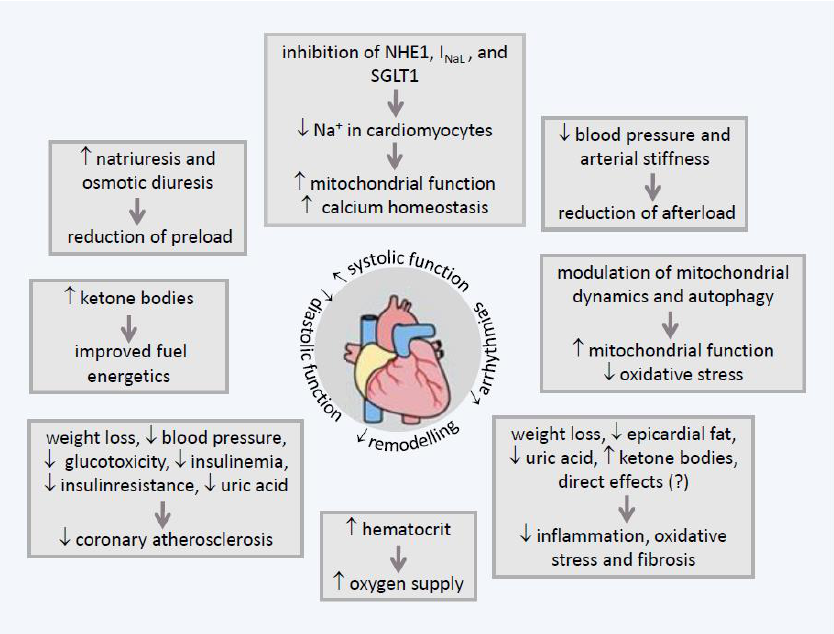
Figure 2. Overview of the main pleiotropic effects of SGLT2-inhibitors on the